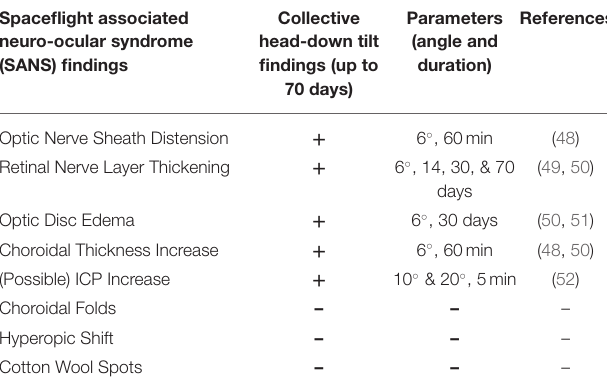
TABLE 1 | Spaceflight associated neuro-ocular syndrome (SANS) findings demonstrated in head-down tilt bedrest